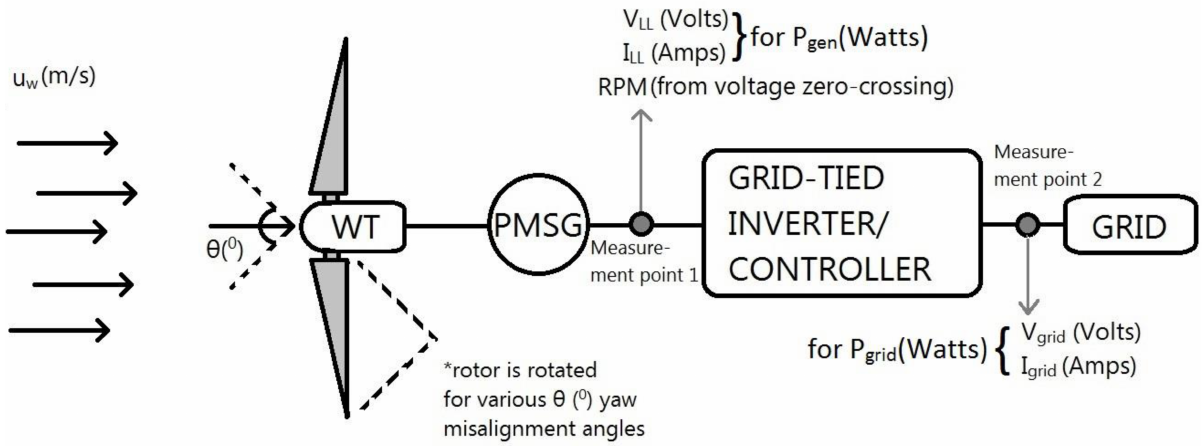
Figure 3. Schematic of configuration of skewed flow losses experiments and inverter losses for the wind turbine (WT) and its permanent magnet synchronous generator (PMSG), together with all relevant measured